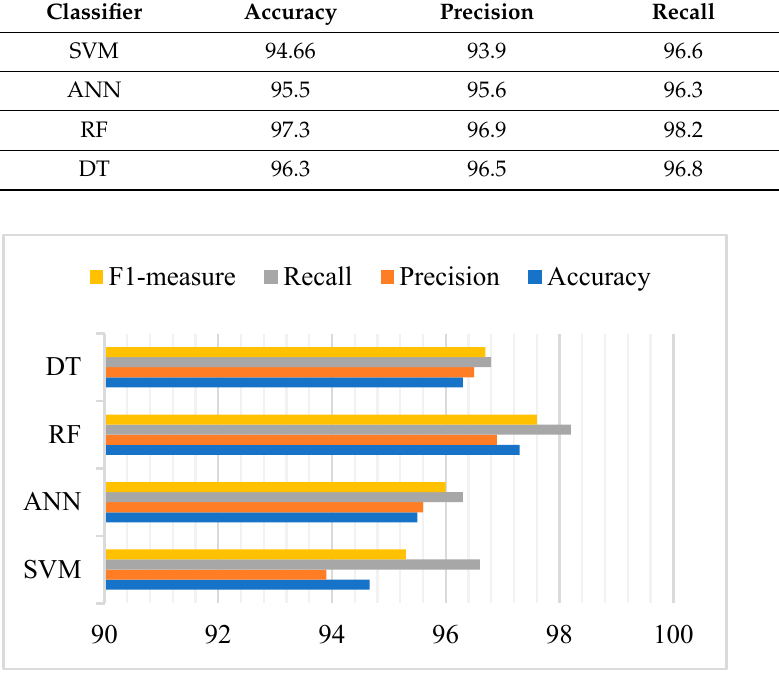
Figure 8. Proposal evaluation results.